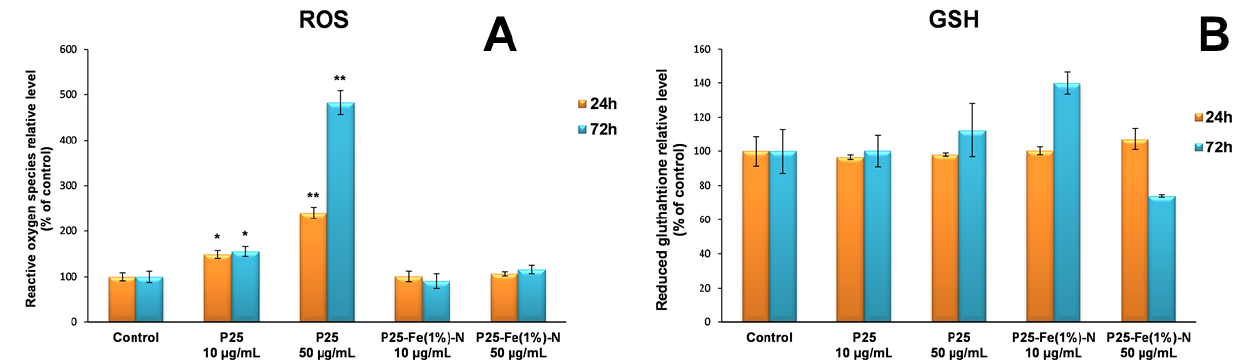
Figure 4. ROS ( A ) and GSH ( B ) levels in normal lung fibroblasts after 24 and 72 h of exposure to different concentrations (10 and 50 μg/mL) of the two TiO 2 NPs samples: P25 Degussa and P25- Fe(1%)-N. Results are expressed as means ± standard deviation (SD) ( n = 3) and represented relative to the untreated cells (control). * p < 0.05 and ** p < 0.01 compared to control.